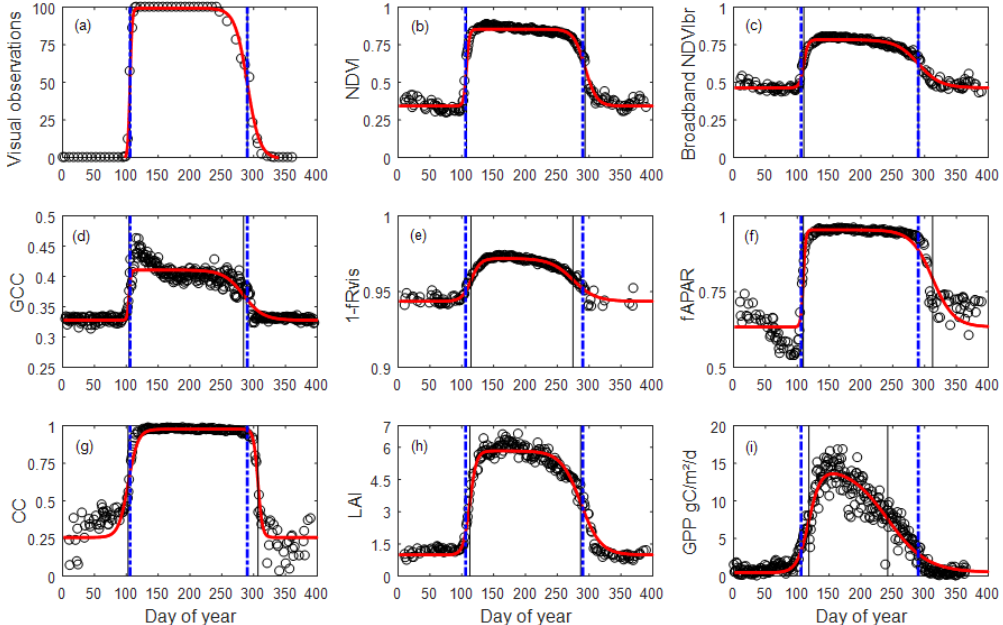
Figure 2. Illustration of 1-year (2015) time series of OBS (a) , NDVI (b) , NDVI br (c) , GCC (d) , 1 − f R vis (e) , f APAR (f) , CC (g) , LAI (h) and GPP (i) in the Fontainebleau–Barbeau forest. Data are shown as empty circles. The red bold continuous curve is the ADS function (Eq. 1) fitted to the time series. For visual observations, data shown are as a percentage of open buds in spring and as a percentage of non-senescent leaves (100% – observed percentage of senescent leaves) in autumn. The percentage of open buds is forced to 100% for the summer growing season and to 0% during the winter dormancy season. Vertical lines: spring and autumn phenology estimates using MOS and MOF (black) and observed dates (BB-OBS and LS-OBS)